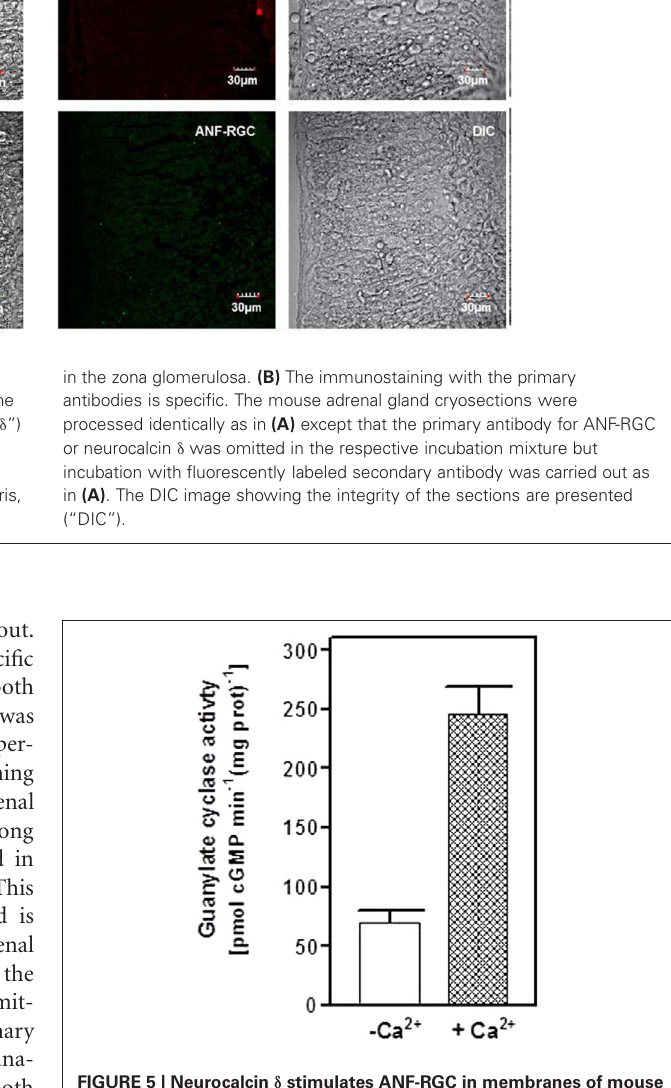
FIGURE 5 | Neurocalcin δ stimulates ANF-RGC in membranes of mouse adrenal gland. Mouse adrenal gland was homogenized in Tris-Mg 2 + buffer pH 7.4 with or without 10 μ M Ca 2 + . The particulate fractions were prepared from each homogenate and assayed for guanylate cyclase activity. The experiment was done in triplicate and repeated two times. The results shown are average ± SD from these